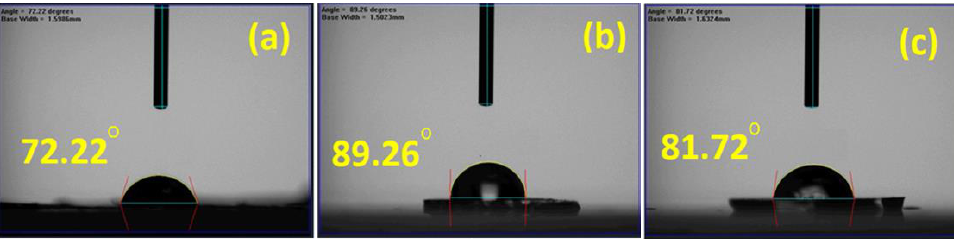
Figure 2. Contact angles of ( a ) BWS-Ag, ( b ) PDMS-BWS-Ag, and ( c ) PDMS-Ag SERS substrates (thickness = 35 nm).